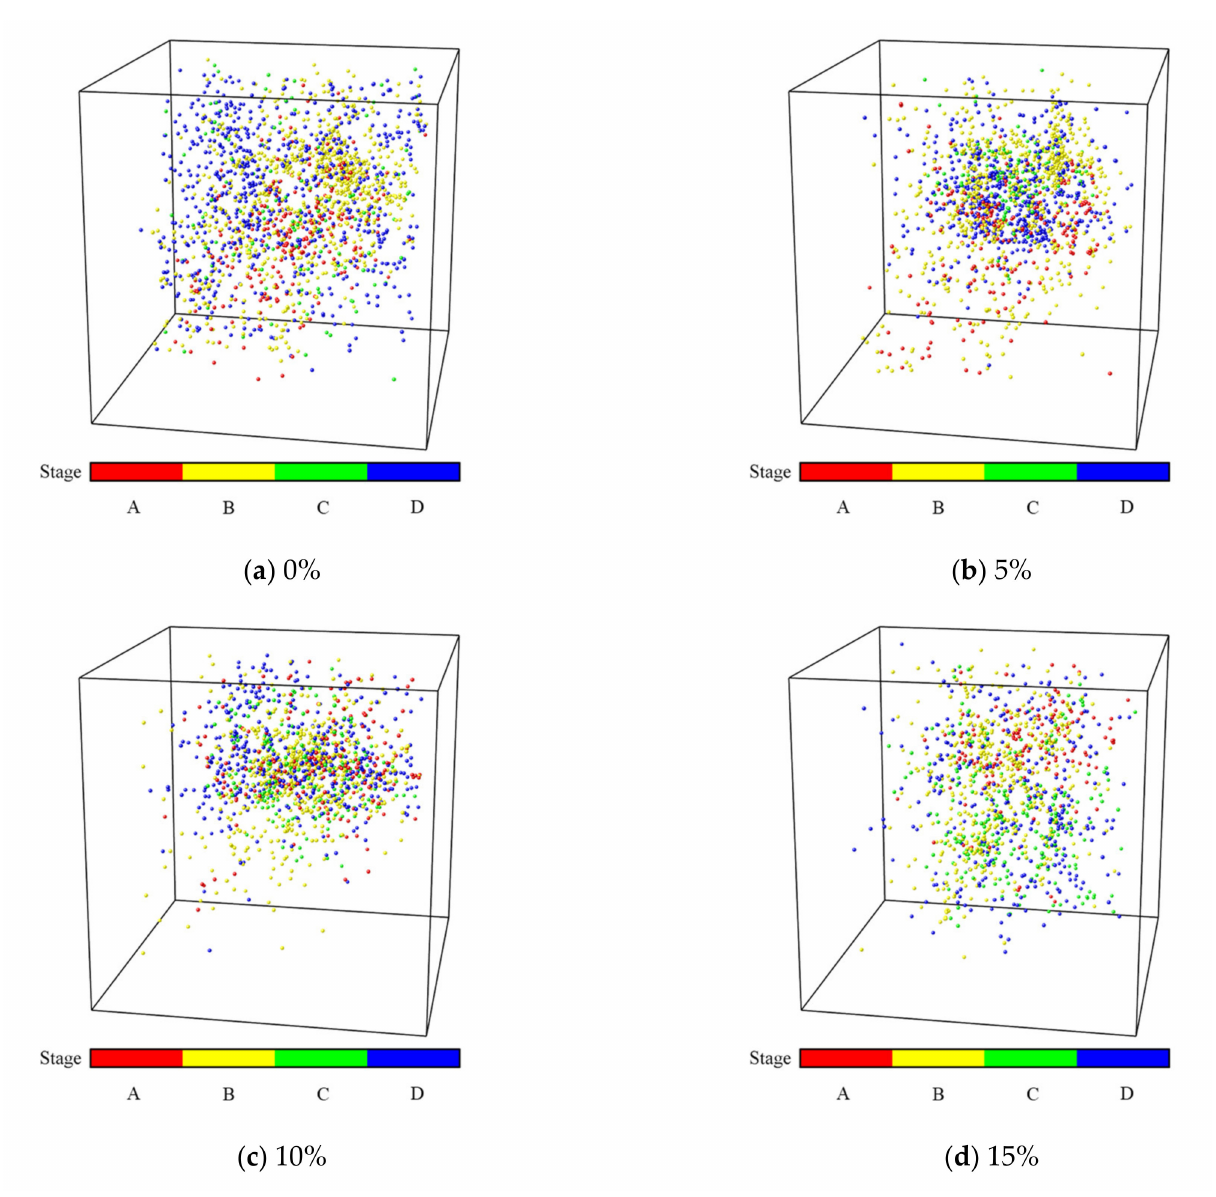
Figure 13. Acoustic emission damage location maps of samples with different quartz sand contents (expansive agent 9%) in different failure stages